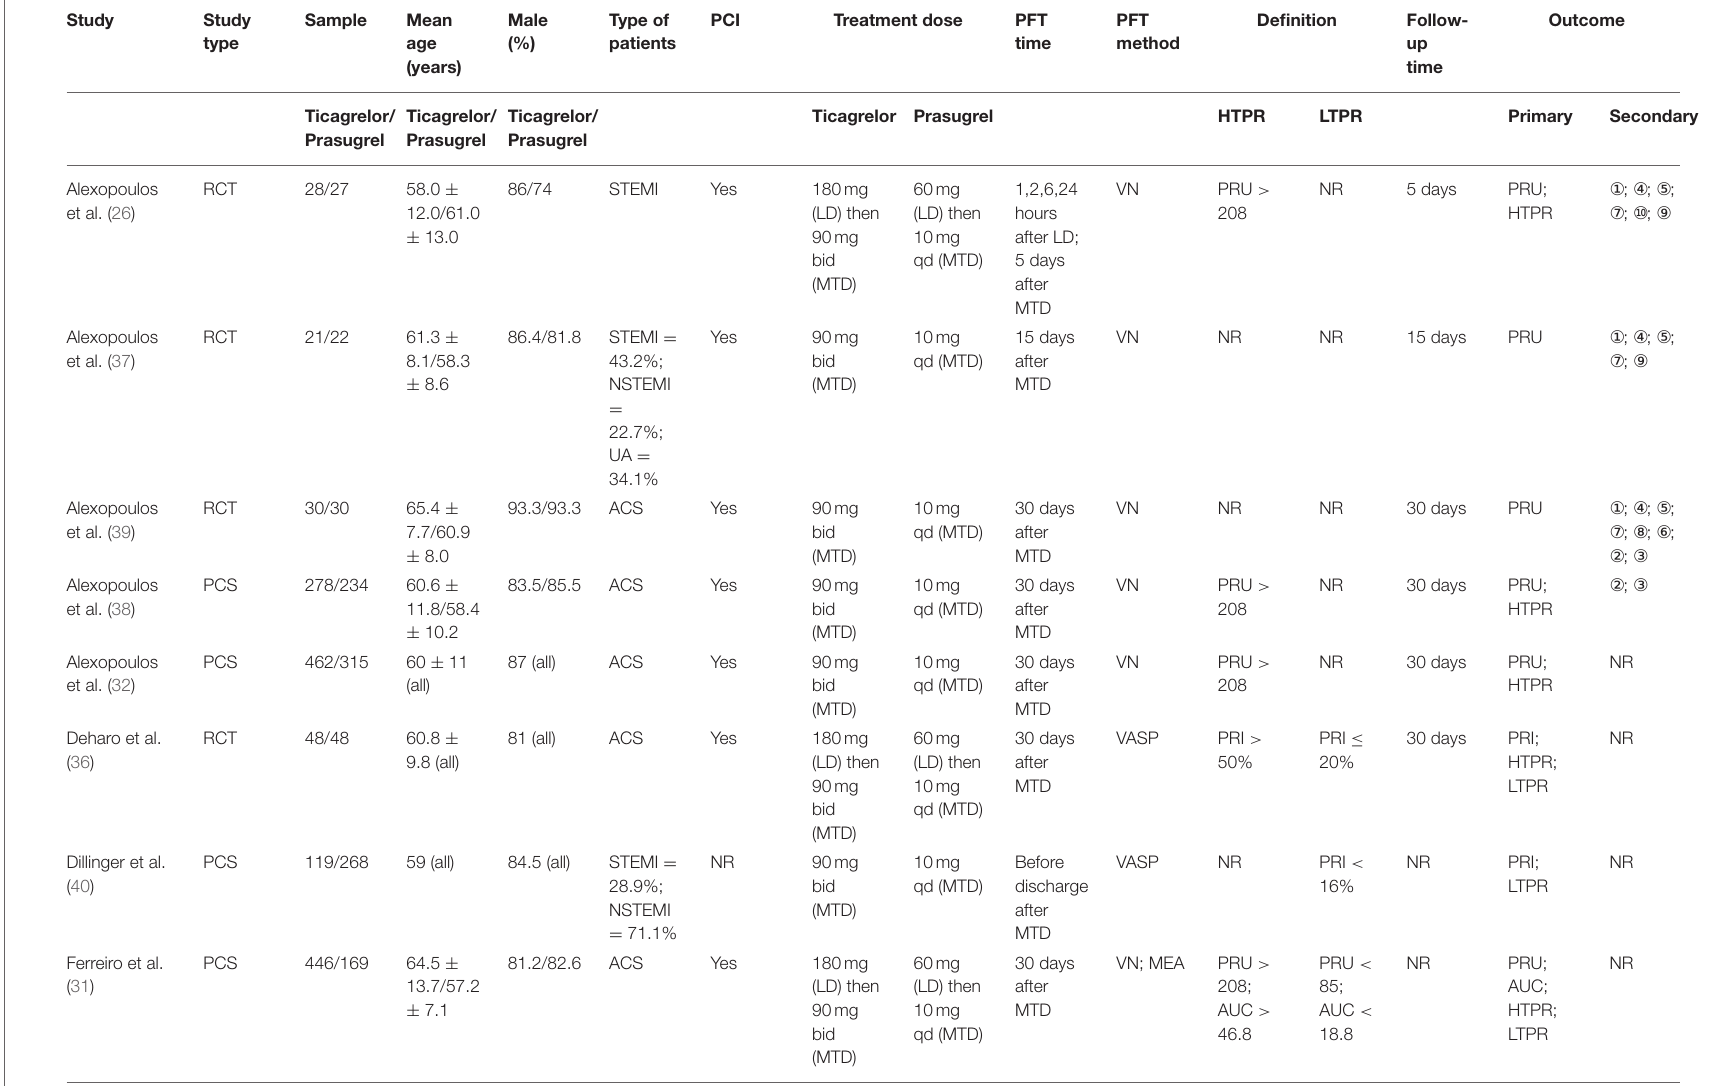
TABLE 2 | Characteristic of selected